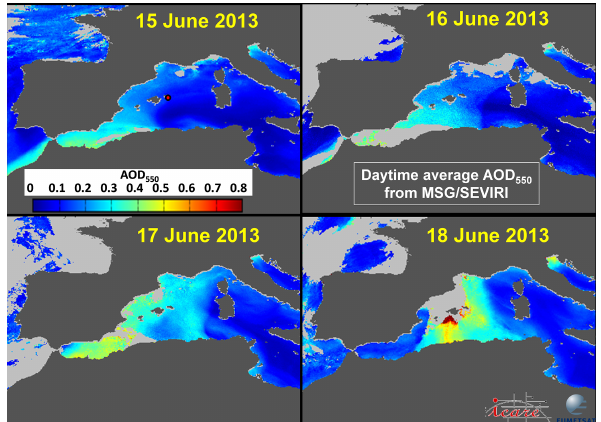
Figure 4. Daytime averaged MSG/SEVIRI-derived AOD at 550nm over seawater from 15 to 18 June 2013, showing the synoptic devel- opment of the dust event. The product is computed by the ICARE Data and Services Center (http://www.icare.univ-lille1.fr) based on the algorithm of Thieuleux et al. (2005). Land is masked in dark grey and clouds over ocean in light grey. The red dot on the 15 June image indicates the balloon launching site and remote-sensing sta- tion on Minorca